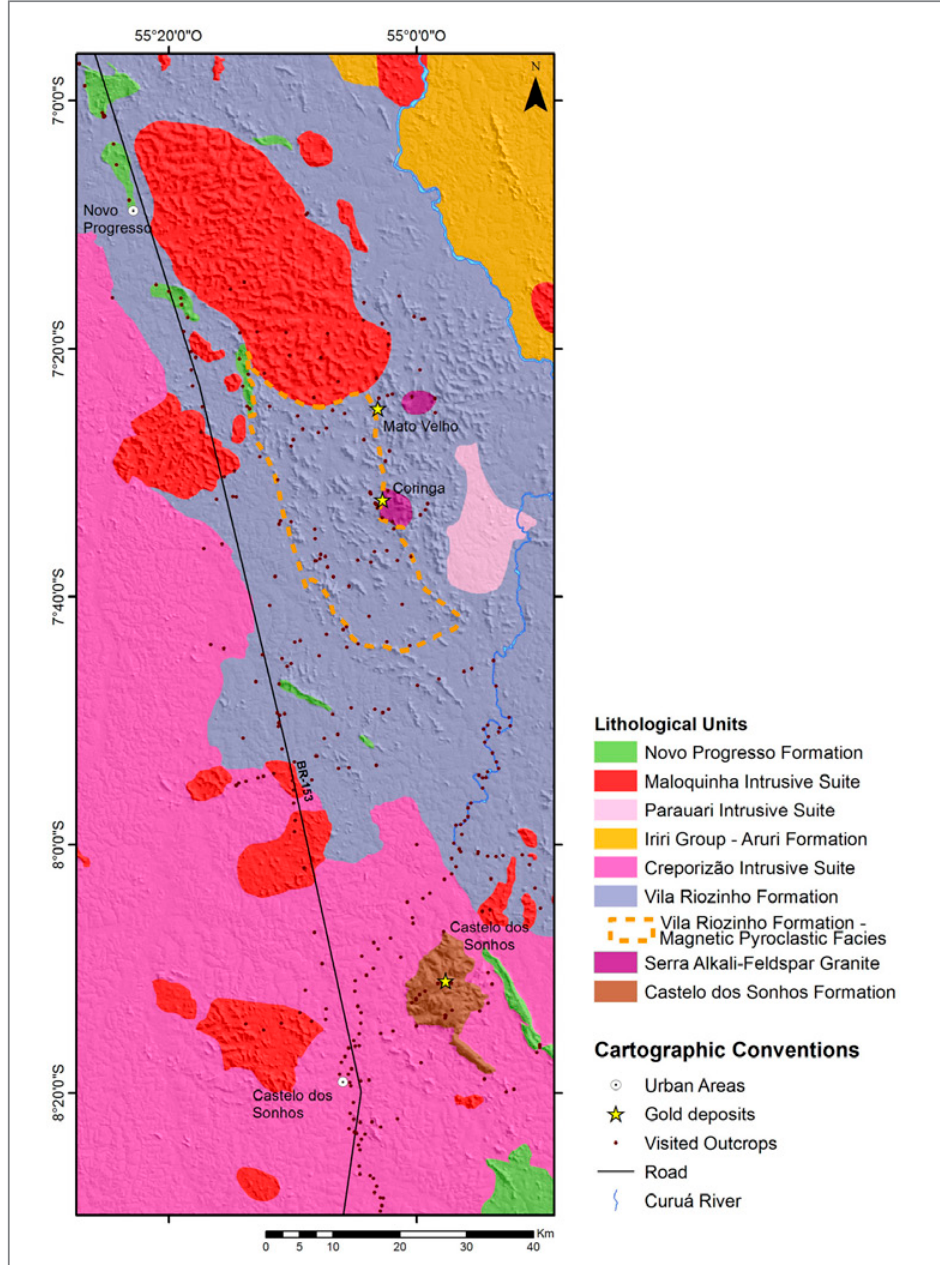
Figure 5 – New Geological map of the SE-Tapajós Gold